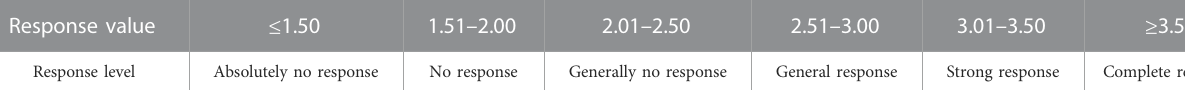
TABLE 5 Classi fi cation of farmers ’ livelihood responsiveness.